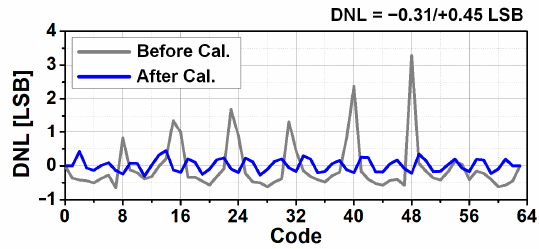
Figure 15. Measured DNL and INL.